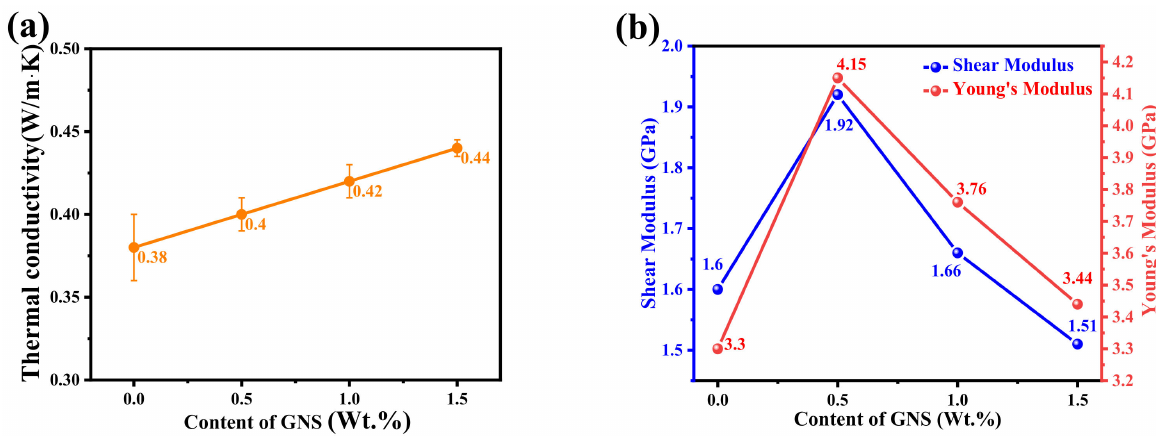
Figure 7. ( a ) Thermal conductivity, ( b ) Young’s Modulus and Shear Modulus of